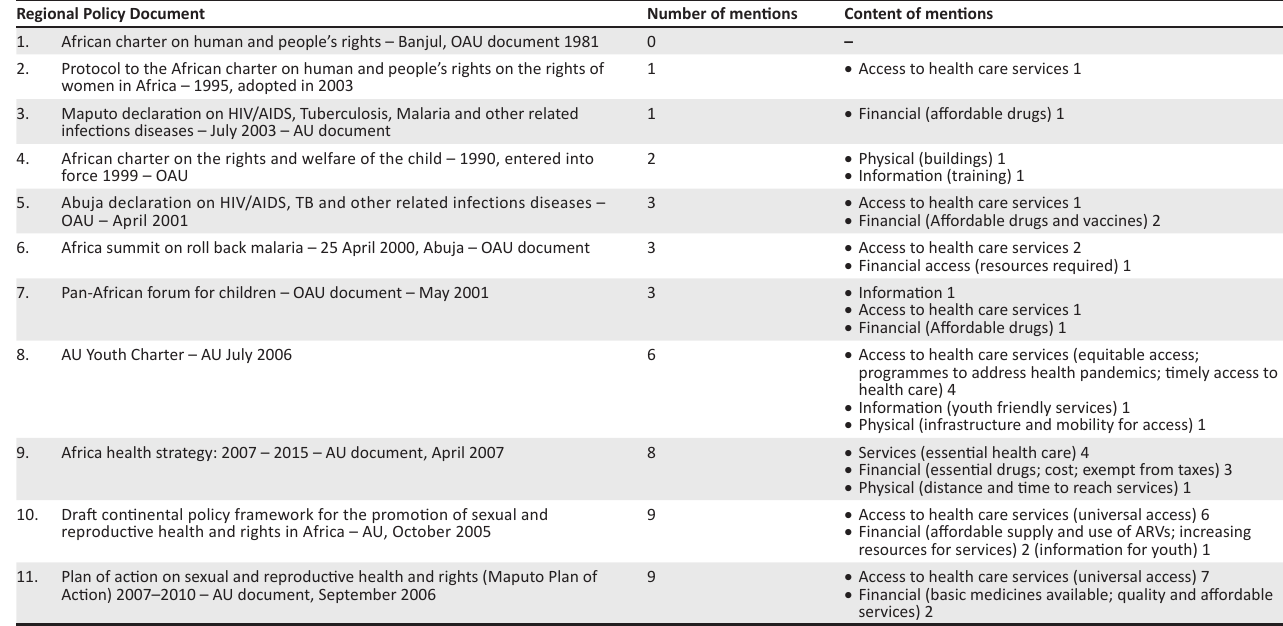
TABLE 5: Analysis of access mentions in eleven regional